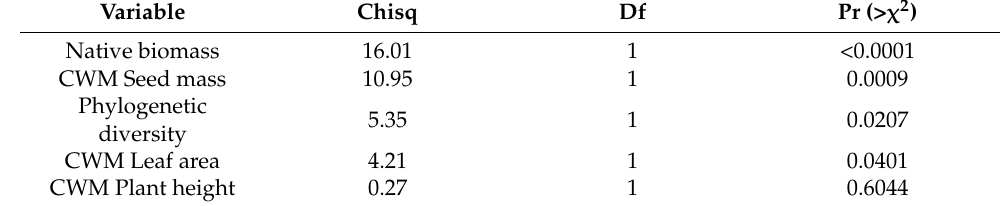
Table 1. Characteristics of the experimental grassland communities that control suppression of the invasive native Jacobaea aquatica (CWM, community-weighted means; biomass without the invasive plant; significant variables in bold). Results of a linear mixed effects model followed by a type III Wald Chi-square test with all variables, and experimental period included as random factor.